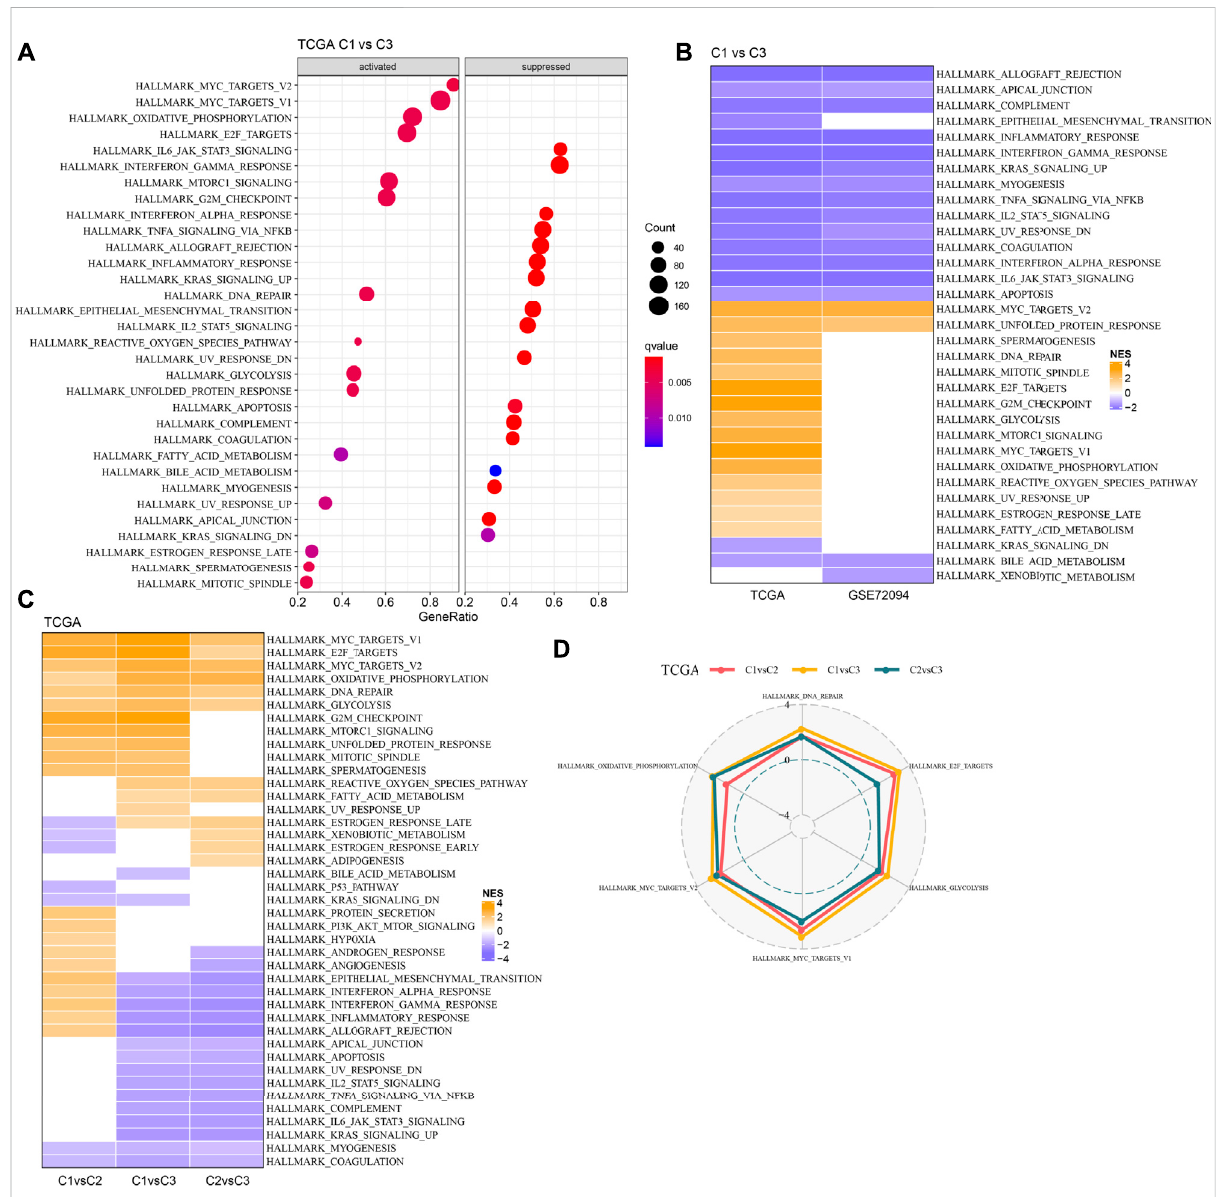
Pathwayanalysisbetweenmolecularsubtypes. (A) .GSEAanalysisresultsofC1vs.C3inTCGAcohort; (B) BubblechartofGSEAanalysisresultsof C1 vs. C3 subtypes in two LUAD cohorts; (C) Bubble chart of GSEA analysis results compared with different molecular subtypes in TCGA cohort; (D) Radar chart of C1 vs. C2 and C2 vs. C3 uniformly activated channels in TCGA